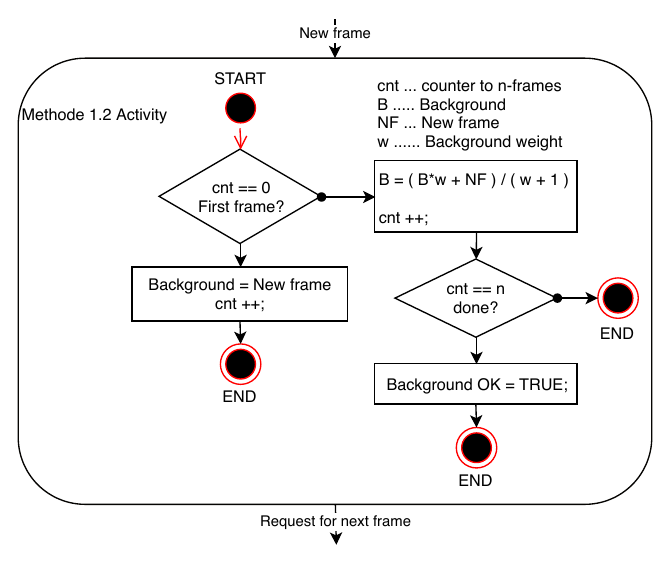
Figure 6. Diagram of Method 1.2